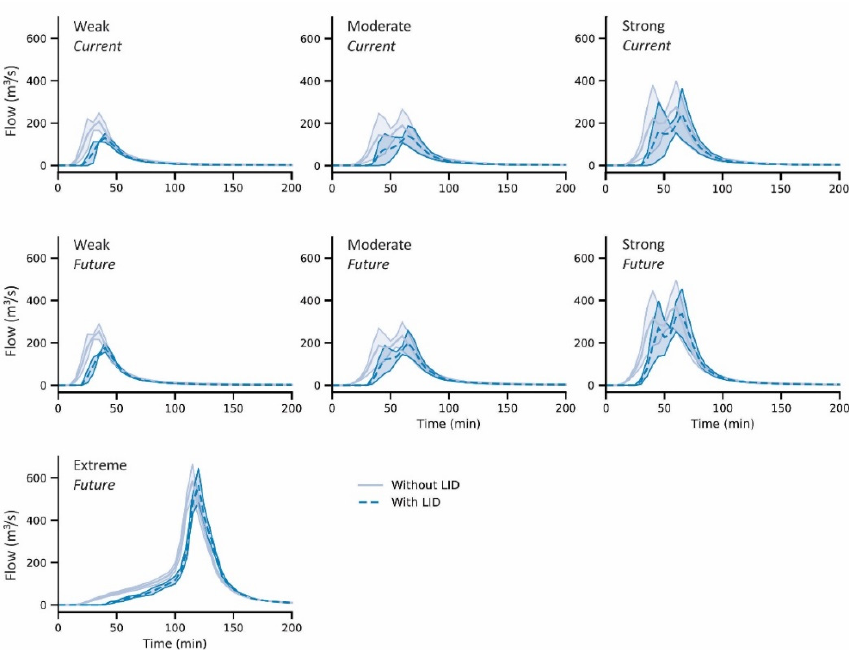
Figure 4. Hydrographs for representative climate scenarios for the current and future period, with and without applying LID practices. Lines represent the average value of the hydrographs, and the shaded area is the confidence interval, considering the variation evaluation for the representative design storms.